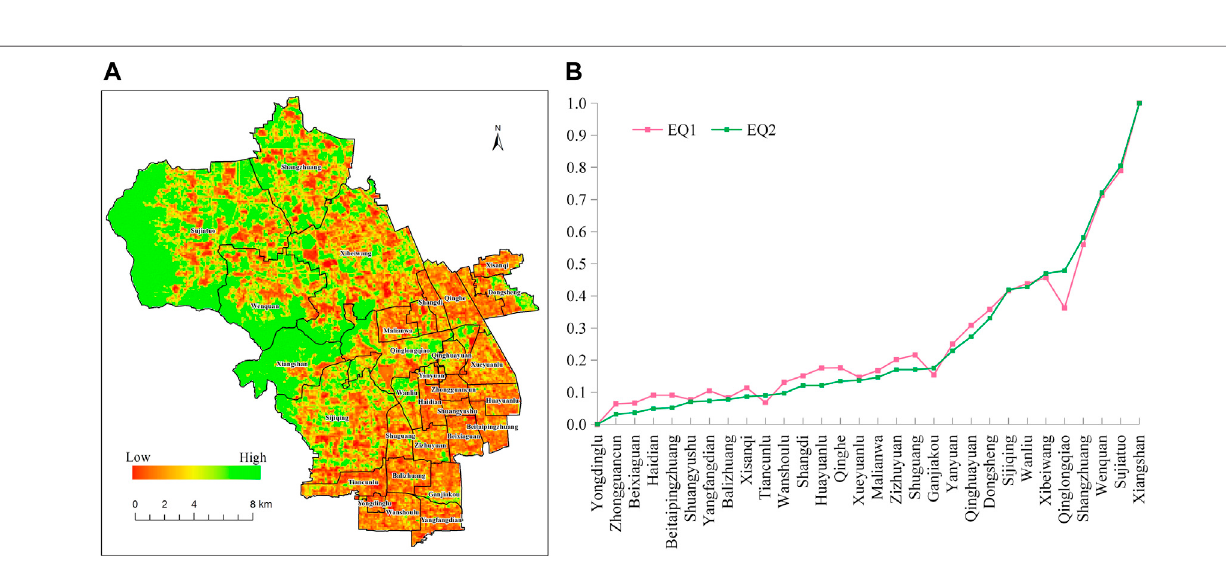
Frontiers in Environmental Science |